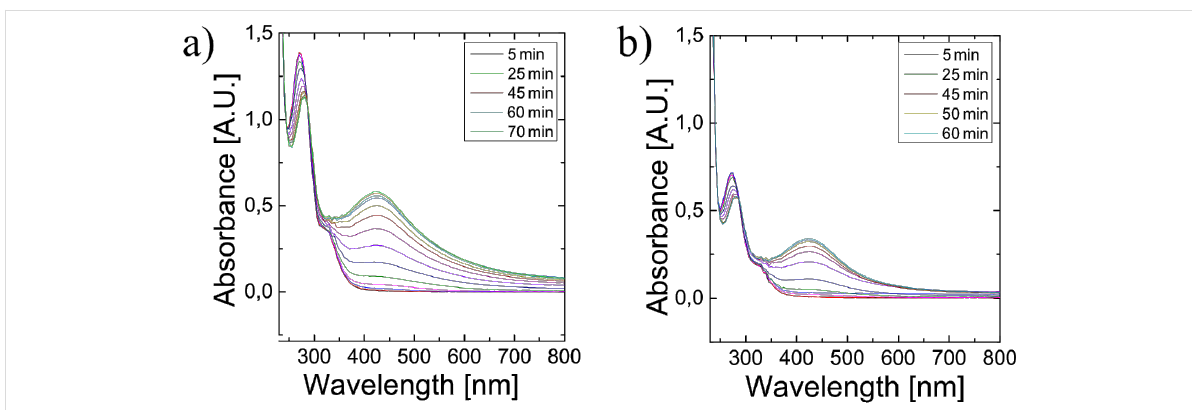
Figure 4: Time evolvement of UV–vis spectra in mixtures of orange extract and AgNO 3 solutions between 5 and 60 minutes after mixing. Figure 4a,b represent different ratios of AgNO 3 solution and orange extract with a 5 times higher ratio of the AgNO 3 solution to plant extract in 4b than in